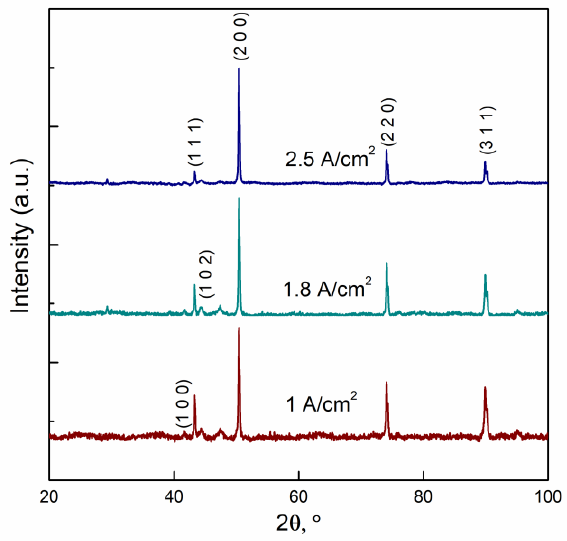
Figure 5. XRD pattern of Co foams electrodeposited from solution 4. Peaks were analyzed according to JCPDS cards No. 01-071-4238 and 01-077-7453.